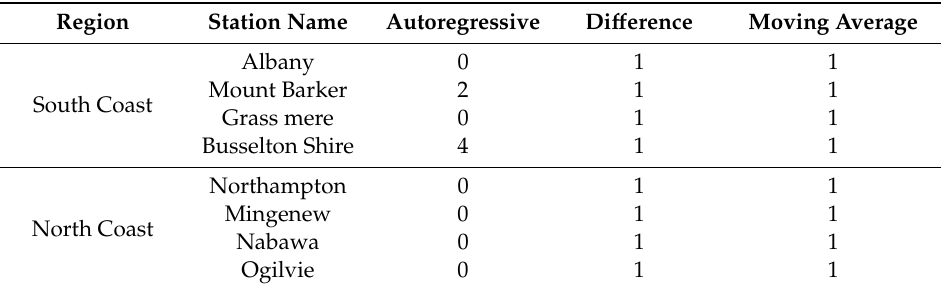
Table 3. ARIMA model input.